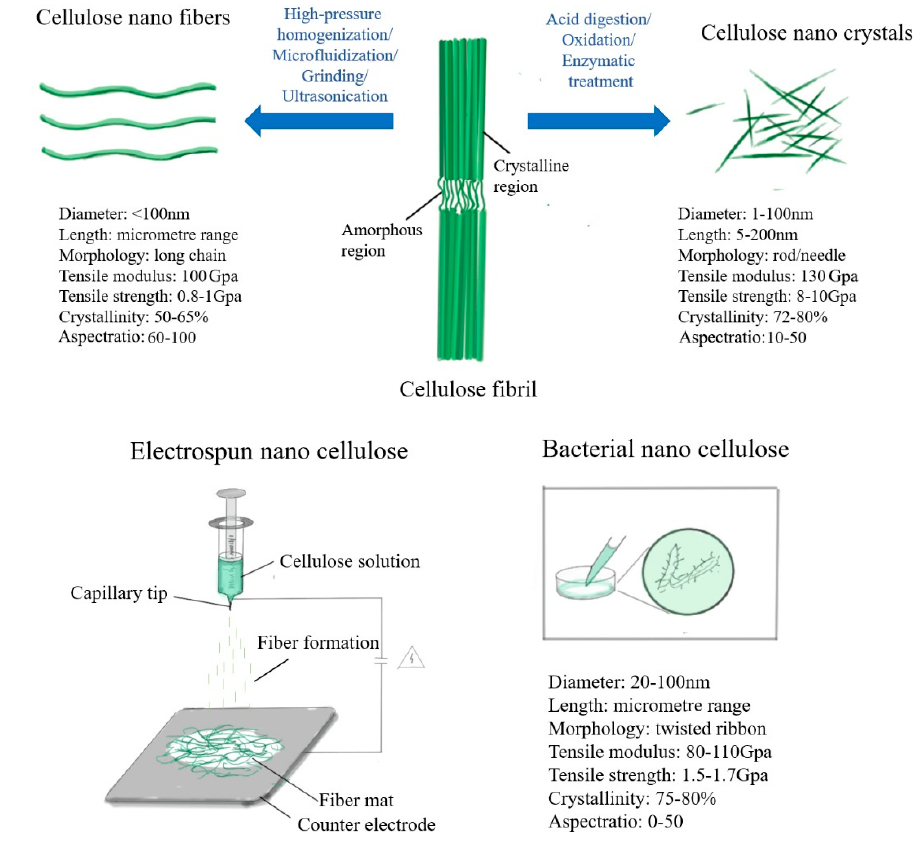
Figure 1. Preparation of CNF, CNC, ECC, and BNC.